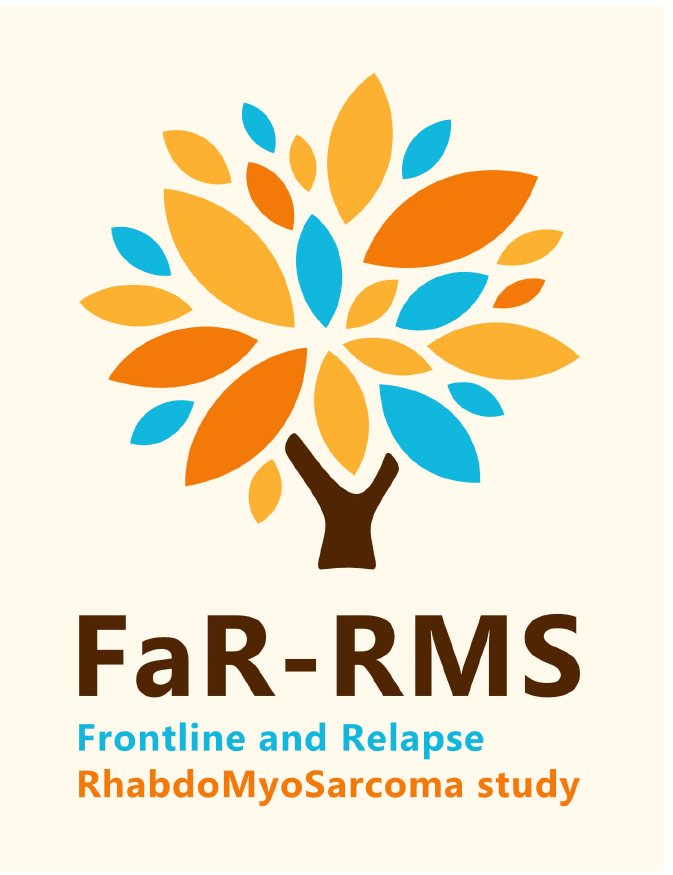
Figure 1. FaR ‐ RMS logo developed in collaboration with young cancer survivors (kindly supplied by Mrs S Wakeling).